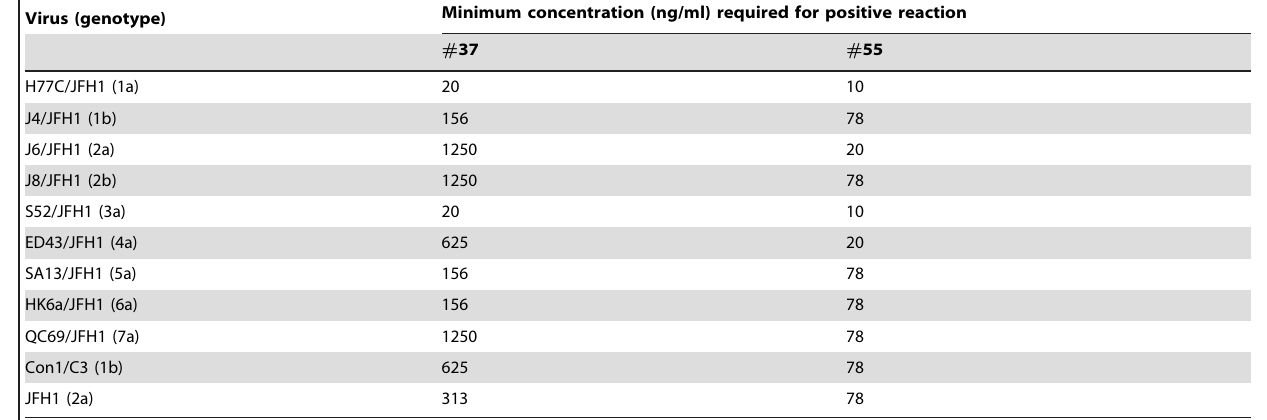
Virus (genotype) Minimum concentration (ng/ml) required for positive